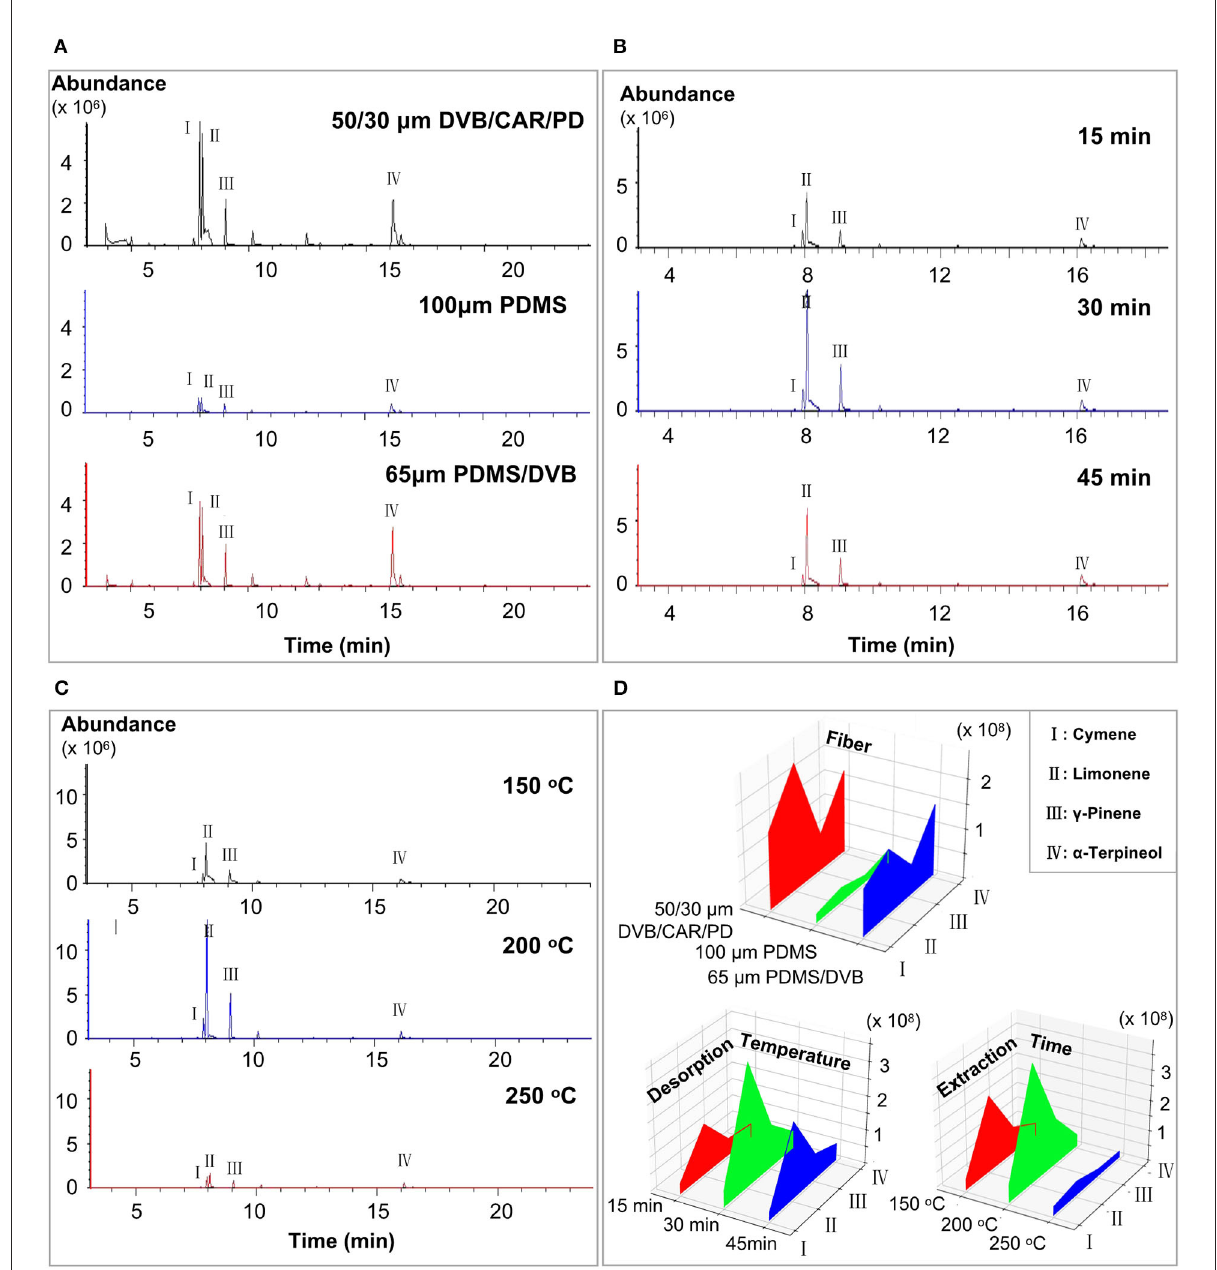
FIGURE1 Chromatograms obtained from different optimized conditions and peak areas of the four main reference components. (A) Chromatograms obtained from 100 µ m PDMS, 50/30 µ m DVB/CAR/PDMS, and 65 µ m PDMS/DVB fibers. (B) Chromatograms obtained at extraction times of 15min, 30min, and 45min. (C) Chromatograms obtained at desorption temperatures of 150 ◦ C, 200 ◦ C, and 250 ◦ C. (D) Peak areas of cymene, limonene, γ -pinene, and α -terpineol detected at different fibers, extraction times, and desorption